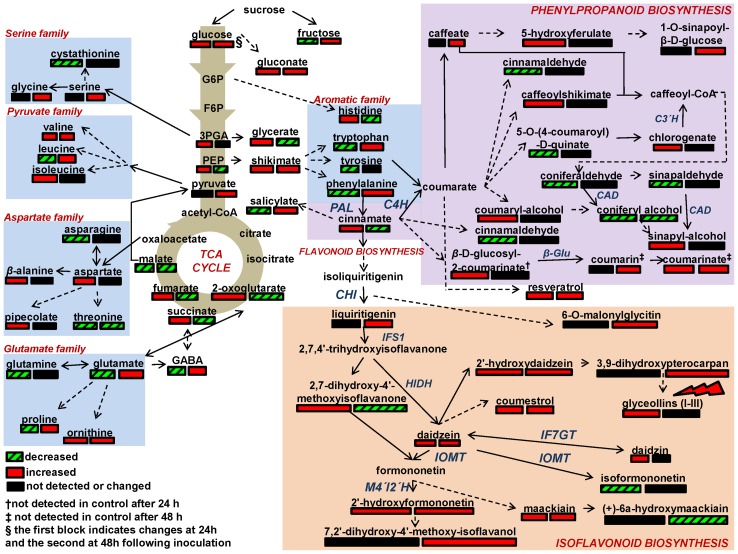
Color-coded fluctuation of the soybean's seedling metabolic network caused by Rhizoctonia solani infection at 24 h and 48 h post-inoculation, including portions of the amino acid biosynthesis, and the isoflavonoid and phenylpropanoid biosynthetic pathways, which were detected as important components of its defense mechanism.Genes in the reference pathway of KEGG for soybean that are hyperlinked to gene entries are displayed. Metabolite fluctuations are coded using a color code based on P-values (P<0.05) performing the Student's t-test and means of scaled and centered PLS regression coefficients (CoeffCS) from five biological replications and a quality control sample per treatment. Dashed lines symbolize multi-step or not fully elucidated reactions and solid lines one-step reactions. [3PGA; 3-phosphoglycerate, isoflavone synthase 1; C3′H; coumaroylquinate (coumaroylshikimate) 3′-monooxygenase, EC: 1.14.13.36, NCBI-GeneID: 100811080, C4H; coumarate 4-hydroxylase, EC: 1.14.13.11, NCBI-GeneID: 100499623, CAD; cinnamyl-alcohol dehydrogenase, EC: 1.1.1.195, NCBI-GeneID: 100777558, CHI; chalconeisomerase (5 isozymes), F6P; fructose-6-phosphate, G6P; glucose-6-phosphate, β-Glu; glucosidase β-glucosidase, EC: 3.2.1.21, NCBI-GeneID: 100779642, HIDH; 2-hydroxyisoflavanone dehydratase, EC: 4.2.1.105, NCBI-GeneID: 547489, IF7GT; isoflavone 7′-O-glucosyltransferase, EC: 2.4.1.170, NCBI-GeneID: 100101902, IFS1; isoflavone synthase 1, EC: 5.4.99.-, NCBI-GeneID: 100037450, IOMT; isoflavone 7′-O-Methyltransferase (14 isozymes), PAL; phenylalanine ammonia-lyase, EC: 4.3.1.24, NCBI-Gene ID: 100787902, PEP; phosphoenolpyruvate].